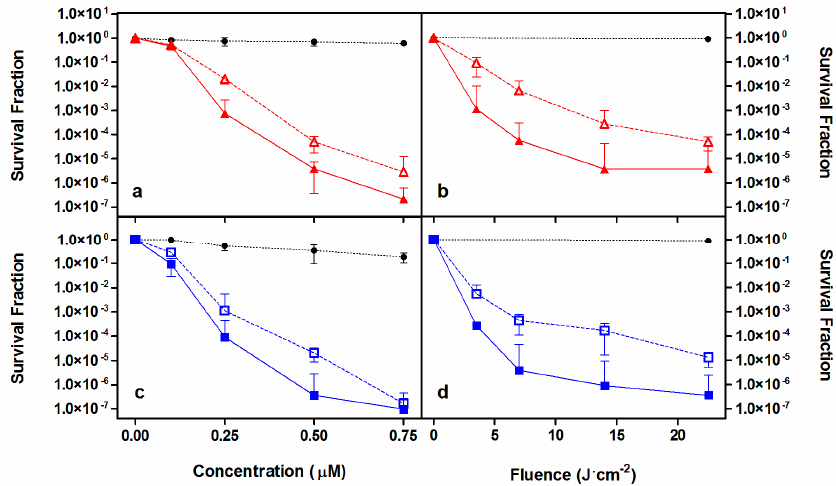
Figure 4. Photoinactivation studies against MRSA. Survival curves of 1 (red, a , b ) and 2 (blue, c , d ) removing (empty symbol) or not (filled symbol) the PS excess from the solution before irradiation. Solid and dashed lines connecting data series provided for visualization purposes. Black symbols are the controls. Fluence was maintained at 22.5 J·cm − 2 ( a , c ) and PS concentration of 500 nM was assayed ( b , d ).